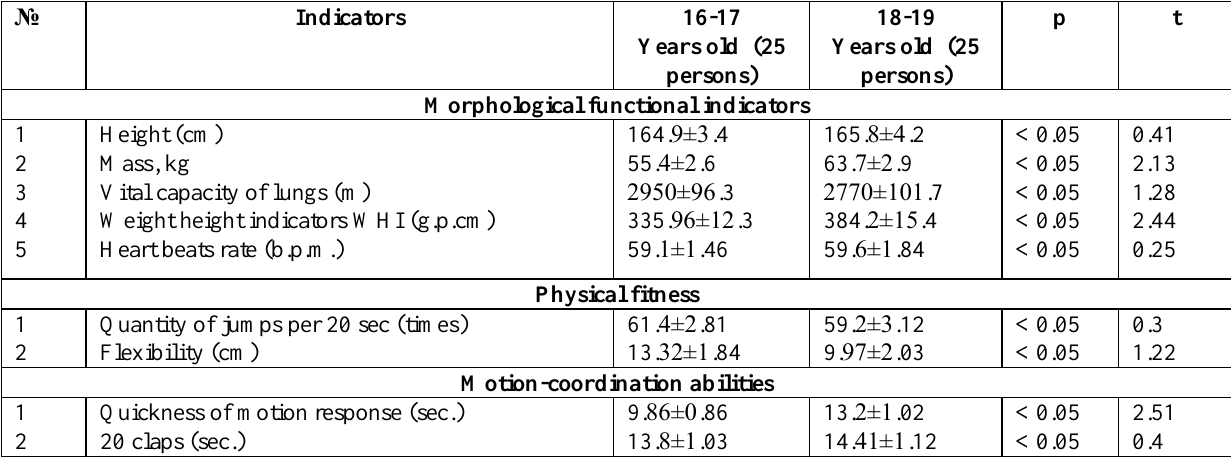
Confidence of changes of first and second year girls students’, training in experimental groups,